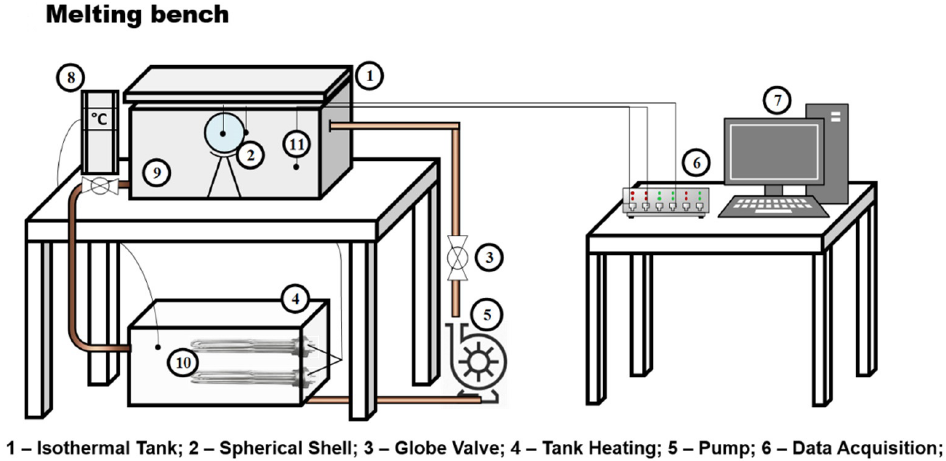
Figure 2. The melting experimental workbench.